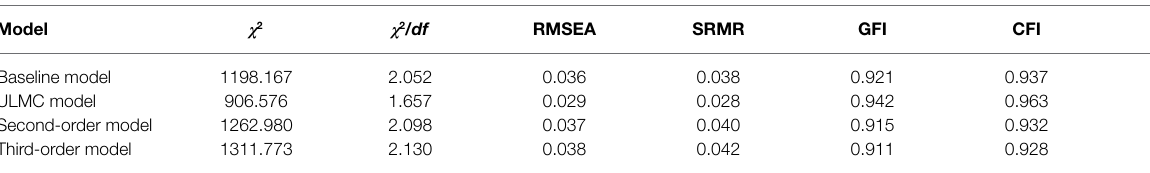
TABLE 7 | A list of models fit.